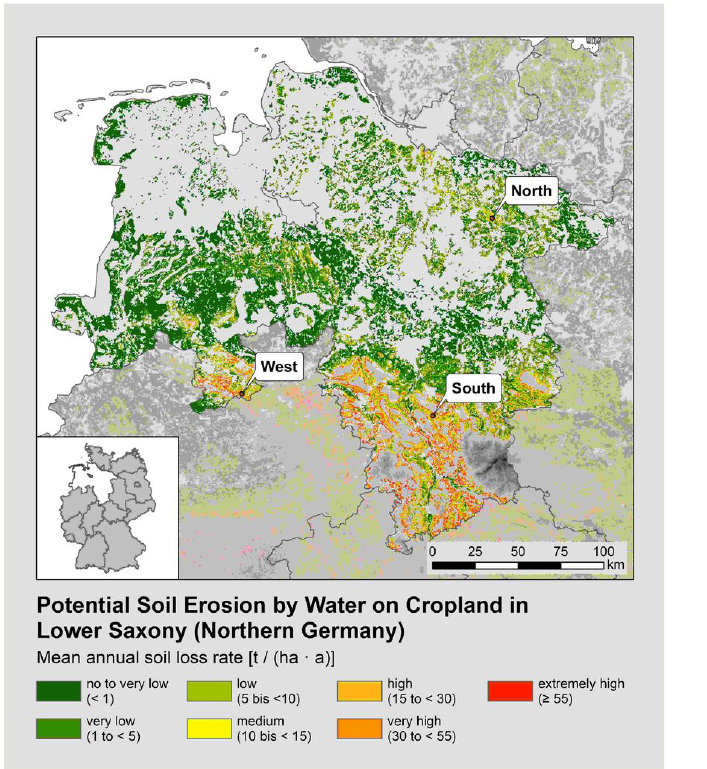
Figure 2. Potential soil erosion by water on cropland in Lower Saxony (Northern Germany) and location of the investigation regions of this study. Data: Map of the potential erosion risk of agricultural soils by water in Germany (Scale 1 : 1.000.0000). Federal Institute for Geosciences and Natural Resources (BGR) 2014.